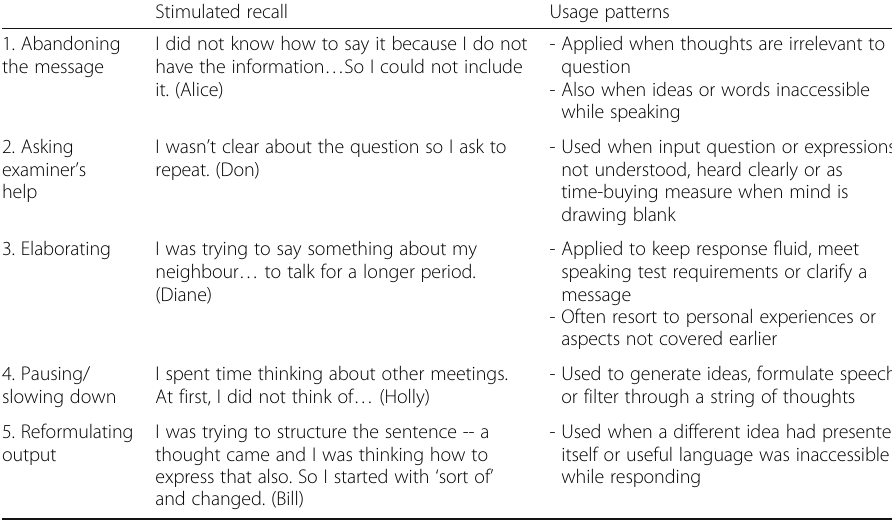
Table 3 Individual communication strategies used and usage patterns